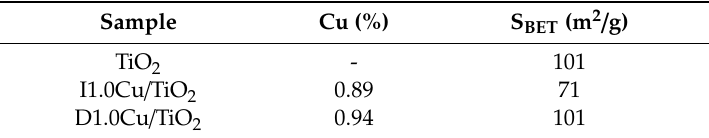
Table 5. Cu actual loading (%) determined by FAAS and specific surface area (S BET ) by nitrogen